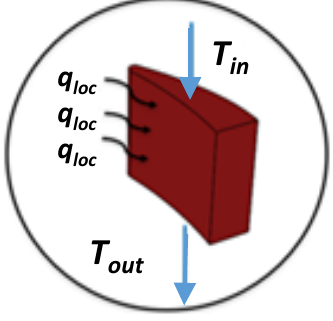
Figure 3. A sector of geometry internal